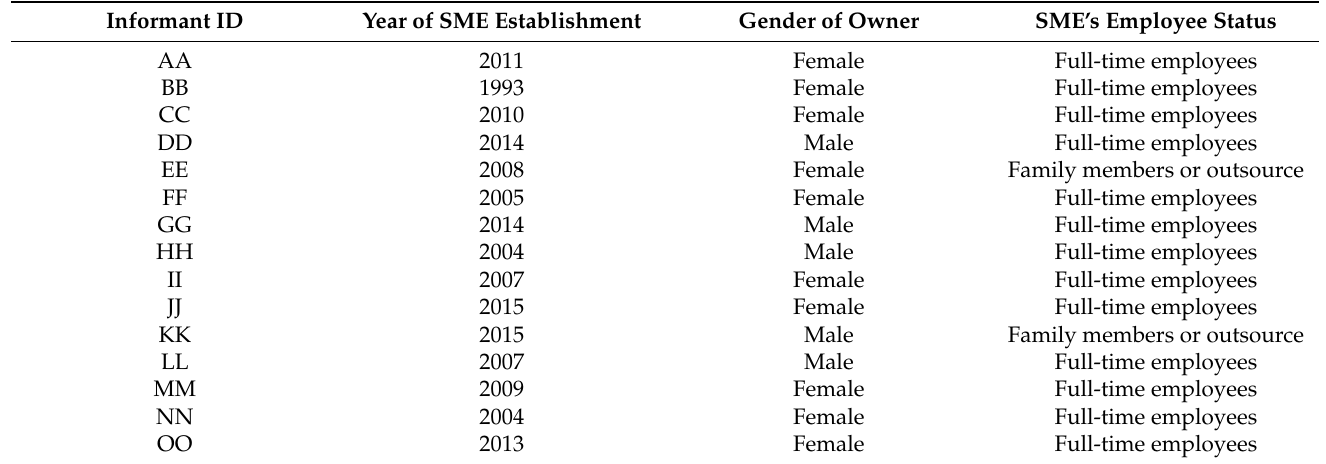
Table 1. Participating SMEs and Informants’